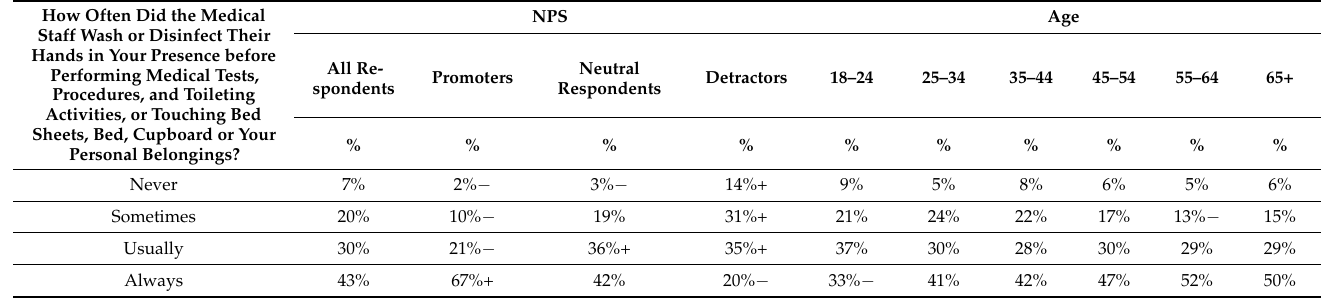
Table 4. Analysis of how often medical staff washed or disinfected their hands in the presence of the patient before performing medical activities or touching bed sheets, bed, cupboard or other personal belongings of the patient.